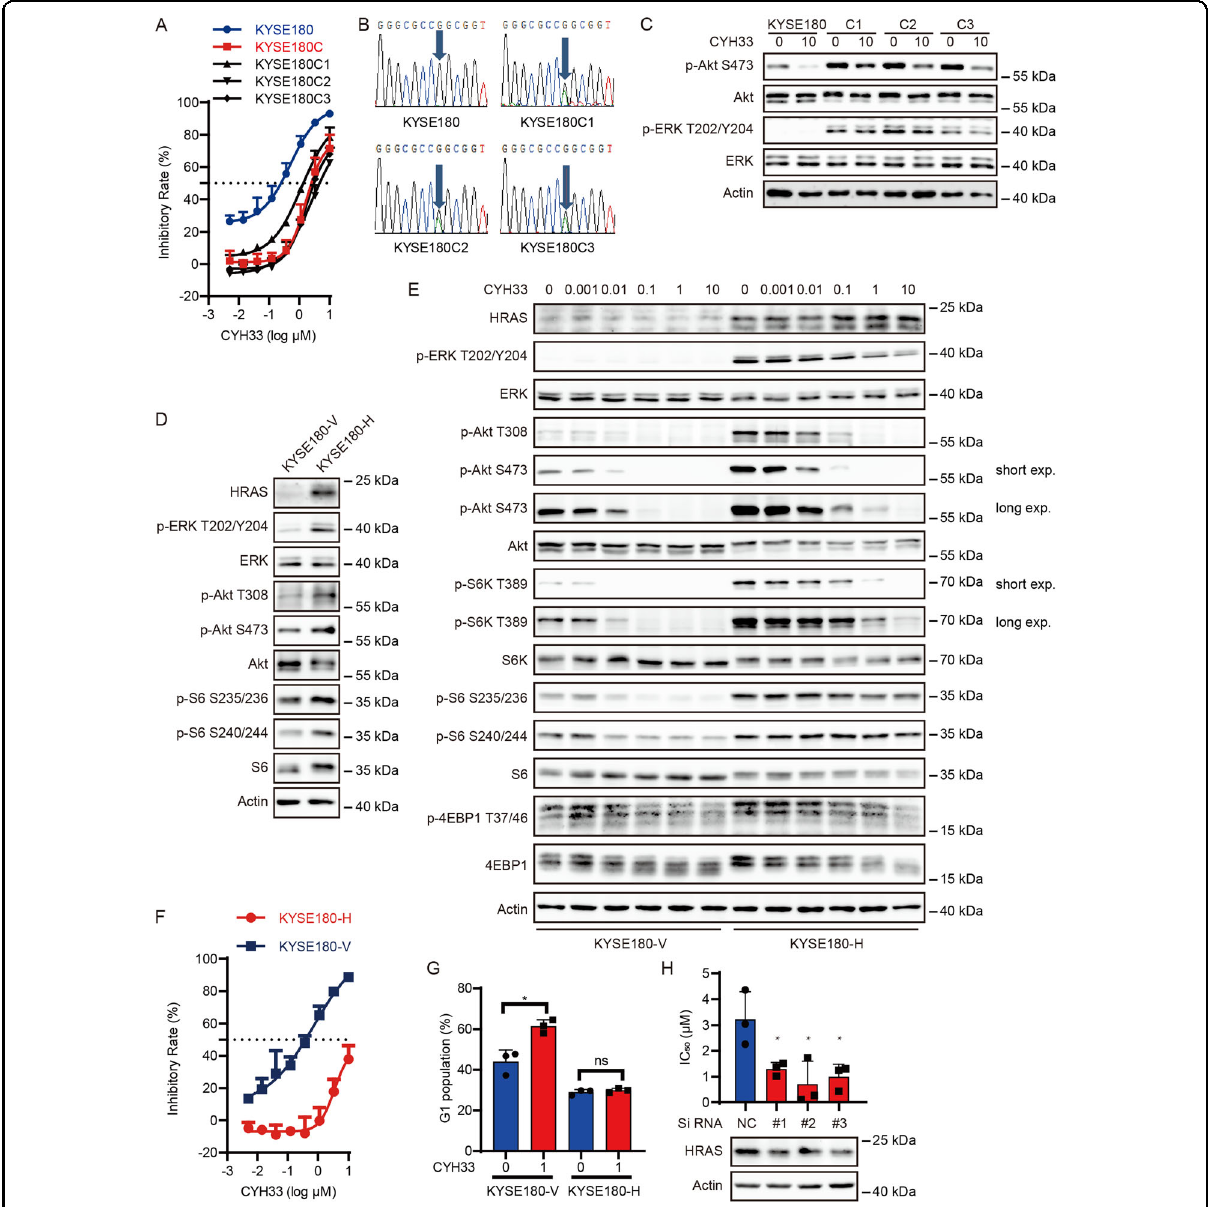
Fig. 4 Gain-of-function mutation in HRAS rendered resistance to CYH33 in ESCC cells. A KYSE180, KYSE180C, and KYSE180C monoclonal cells were incubated with CYH33 for 72 h and cell proliferation was measured with SRB assay ( n = 3). B Sanger sequencing of HRAS showing heterozygous mutation of HRAS at codon 12 in KYSE180C monoclonal cells. C KYSE180 and KYSE180C monoclonal cells were treated with CYH33 at 10 μ M for 1 h, and cell lysates were subjected to western blotting with indicated antibodies. D KYSE180 cells were transfected with plasmid expressing HRAS G12S mutant (KYSE180-H) or a vehicle plasmid (KYSE180-V), and cell lysates were subjected to western blotting with indicated antibodies. E KYSE180-V and KYSE180-H cells were treated with CYH33 at indicated concentrations for 1 h, and cell lysates were subjected to western blotting with indicated antibodies. F KYSE180-V and KYSE180-H cells were treated with CYH33 for 72 h and cell proliferation was measured with SRB assay ( n = 3). G KYSE180-V and KYSE180-H cells were incubated with CYH33 for 24 h and cell cycle distribution was analyzed by fl ow cytometry ( n = 3). H KYSE180C1 cells transfected with siRNAs targeting HRAS (#1, #2, and #3) or negative control siRNA (NC) were treated with CYH33 for 72 h and cell proliferation was measured with SRB assay ( n = 3). Data shown are mean + SD or representative from three independent experiments. Differences between indicated groups were analyzed using one-way ANOVA with Tukey multiple group comparison test. * P <